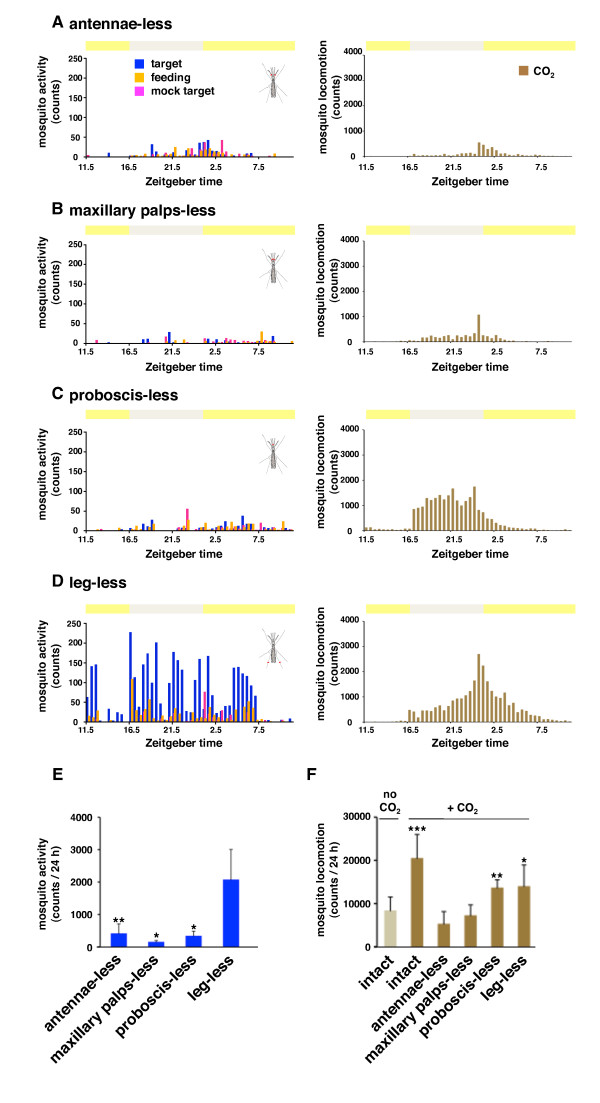
Segregation of CO2 and heat-sensing behavior mediated by mosquito proboscis. (A-D) Effect of appendage-ablations on the selected host-seeking behavior (left column) and CO2-activated locomotion (right column). Behaviors of each group of 60 female mosquitoes lacking antenna (A), maxillary palps (B), proboscis (C), or leg (D) were monitored for 24 h by the automated-device. CO2 was delivered intermittently (2 sec every 15 min) during the 24 hours assay. Each graph shows selected host-seeking (blue), sugar-feeding (orange), background (magenta), and CO2-activated locomotion behavior (dark orange). (E) Total activity counts of selected host-seeking behavior during the 24 hours assay. Note that antenna-, maxillary palps-, and proboscis-less mosquitoes show significantly-reduced activity compared to the leg-less mosquitoes (**p < 0.01 and *p < 0.05, t-test; mean ± SD, n = 5). (F) Total activity counts of CO2-activated locomotion during the 24 hours assay. Note that antenna- and maxillary palps-less, but not proboscis-less mosquitoes show significantly-reduced locomotion compared to the intact mosquitoes without CO2 (***p < 0.005, **p < 0.01 and *p < 0.05, t-test; mean ± SD, n = 5).